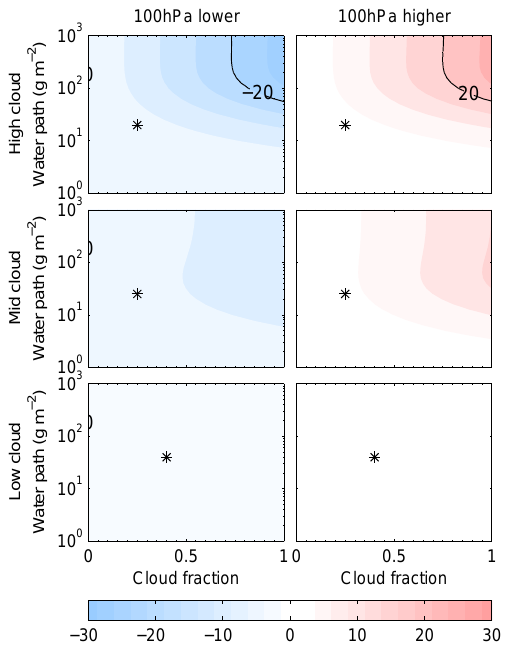
Fig. 13. Cloud radiative forcing with changed cloud height relative to standard height clouds (see Fig. 11). Colour/contour scale is in Wm − 2